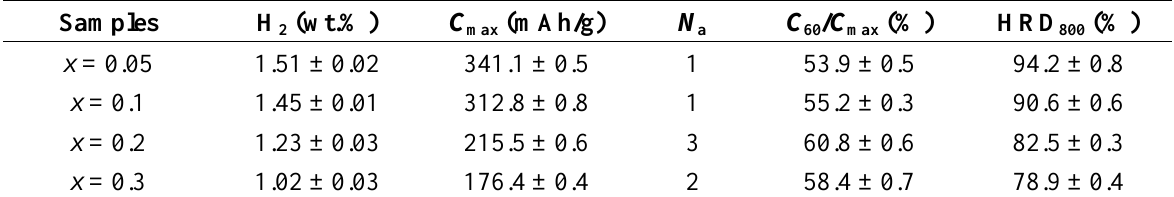
Figure 4. Relationship between hydrogen capacity (discharge capacity) and phase abundance of ZrNi . 3 Table 2. The electrochemical and gaseous hydrogen storage properties